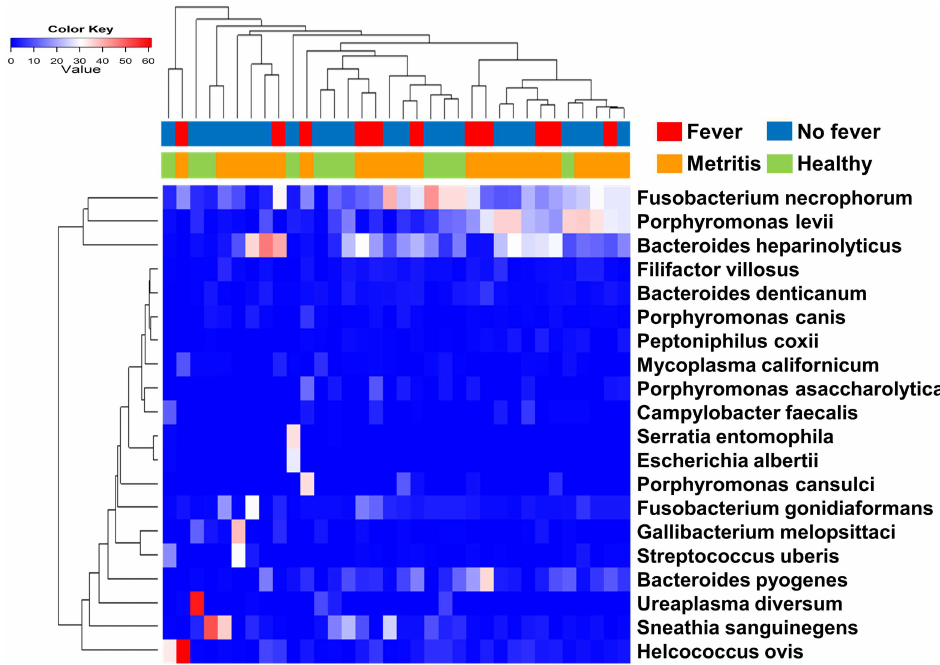
Fig 3. Heat map analysis with the dendrogram based on Euclidean distance. Columns represent individualcows and rows represent 20 bacterial species. The relative abundance of bacteria was presented by color in each cell. Under the dendrogram the first bar shows whether cows had fever and the second bar indicates whether cows had metritis.